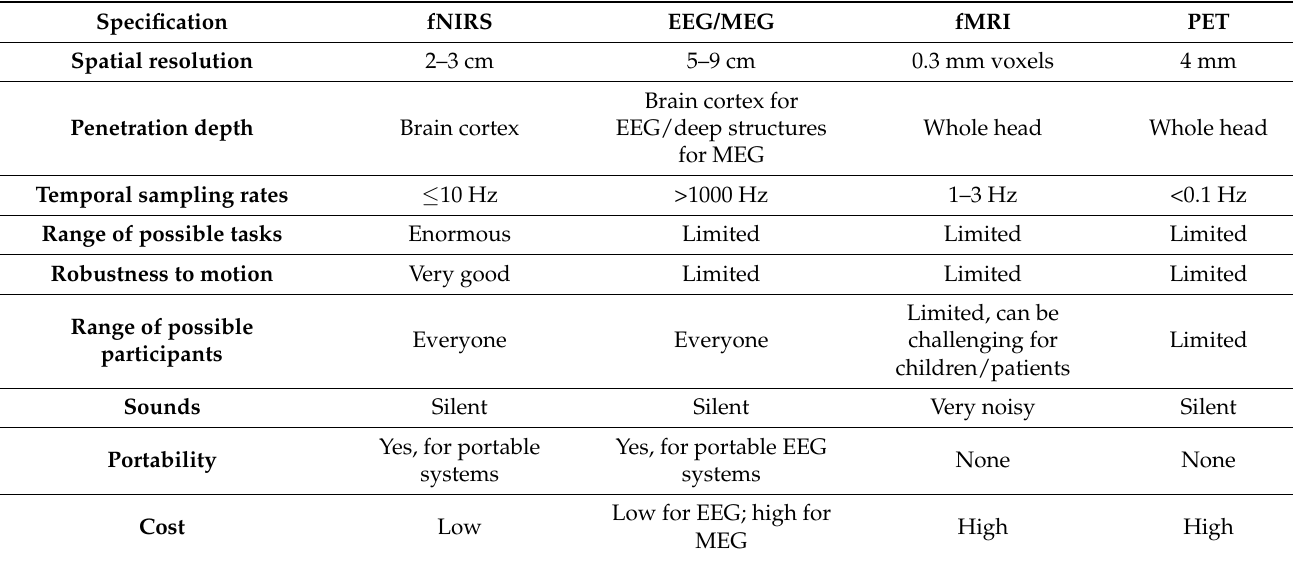
Table 1. Comparison of four neuroimaging